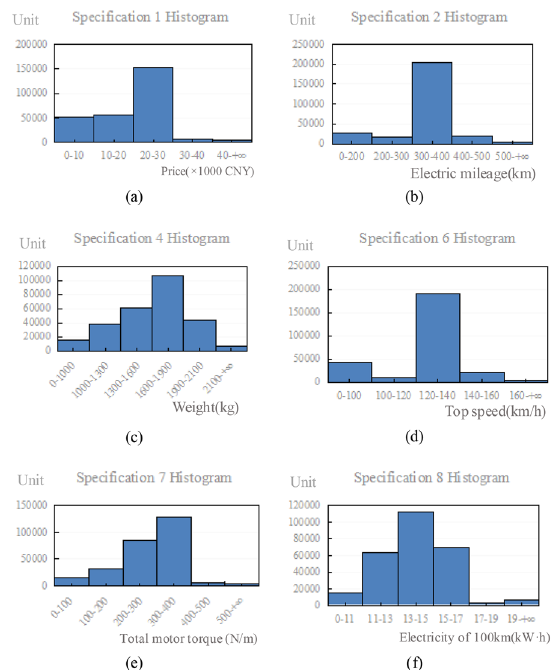
Figure 8 Part of specification frequency analysis